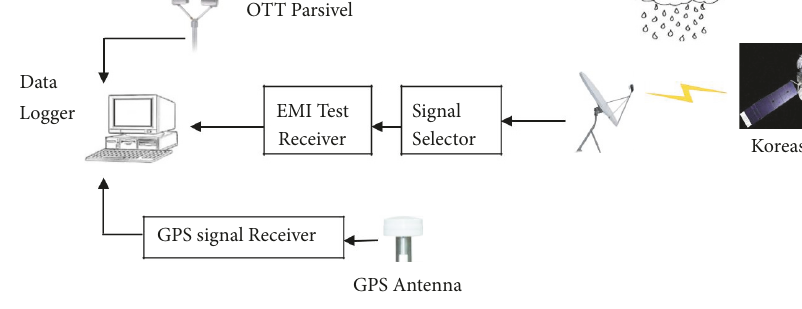
Figure 1: System diagram of experimental setup